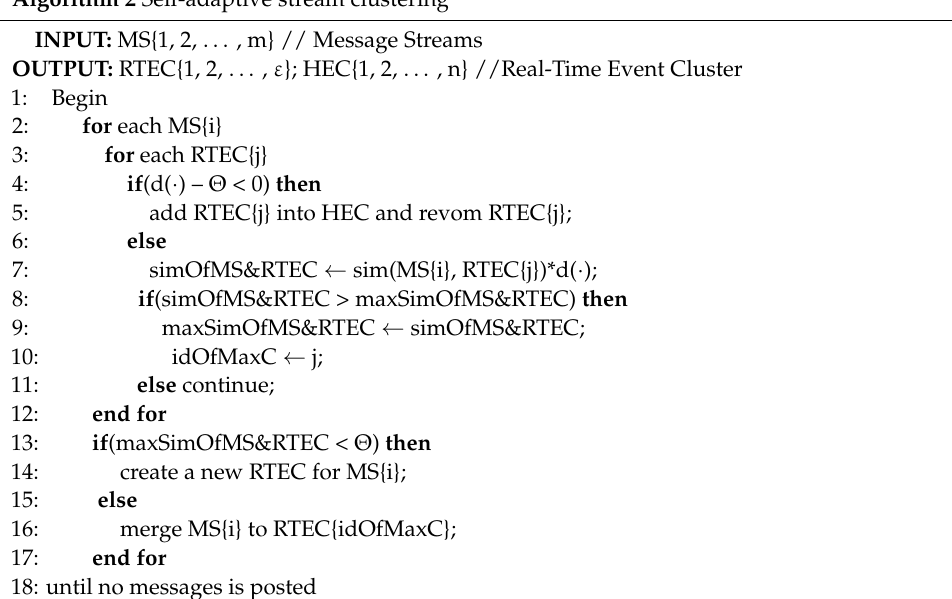
Algorithm 2 Self-adaptive stream clustering